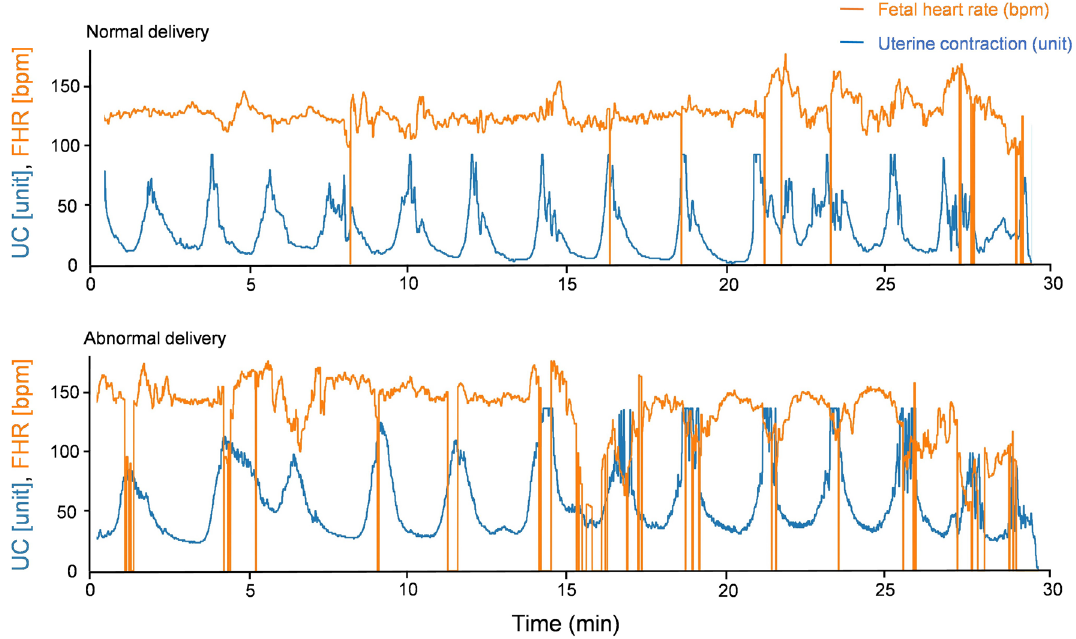
Figure 2. Representative raw CTG records from the normal and abnormal deliveries. Top: CTG records from a normal delivery. Bottom: CTG records from an abnormal delivery. The orange line represents fetal heart rate (bpm), and the blue line represents uterine contraction